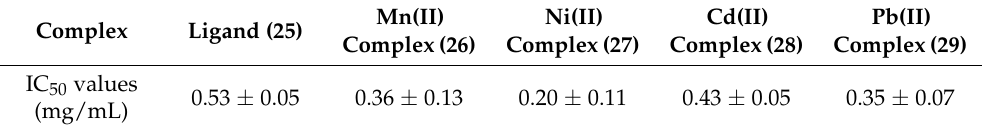
Table 3. DPPH scavenging ability (IC50, mg/mL) of the studied compounds [142]. Complex Ligand